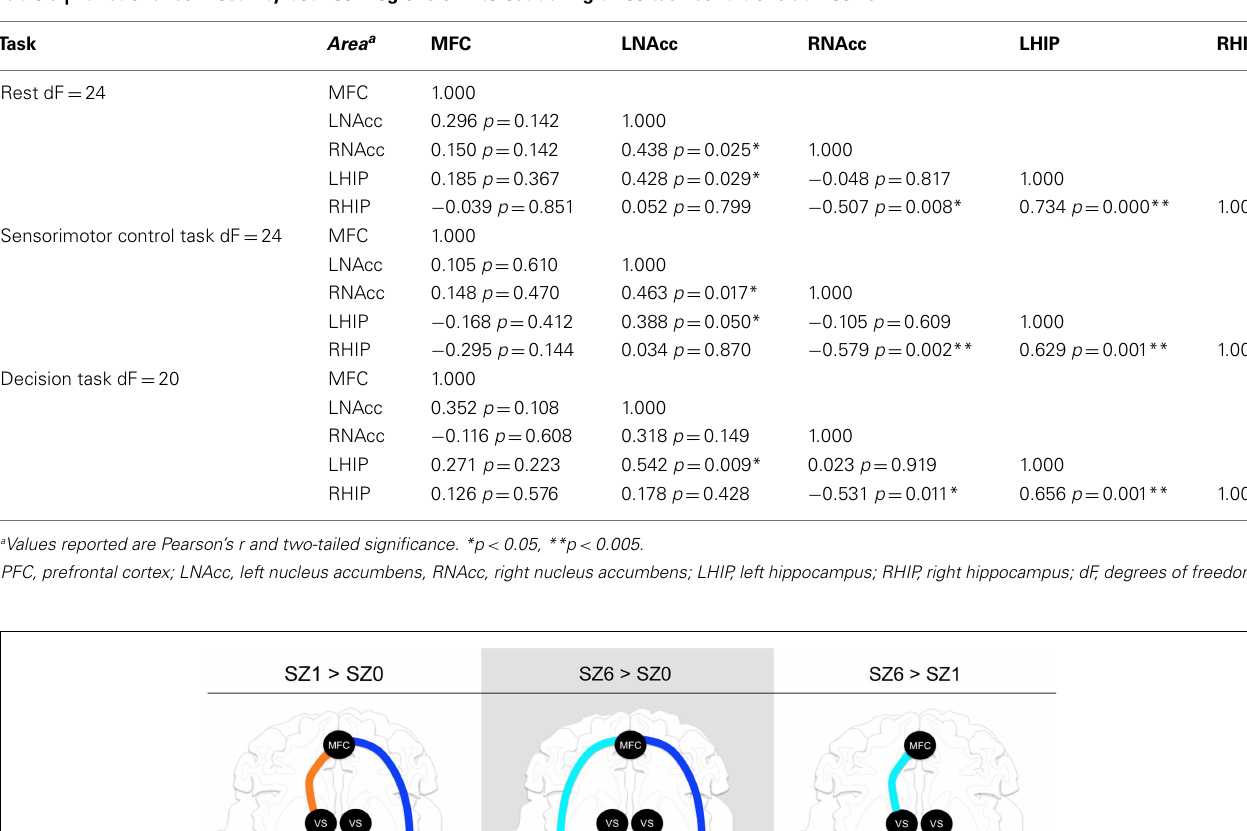
Table 9 | Functional connectivity between regions of interest during three task conditions at week six.